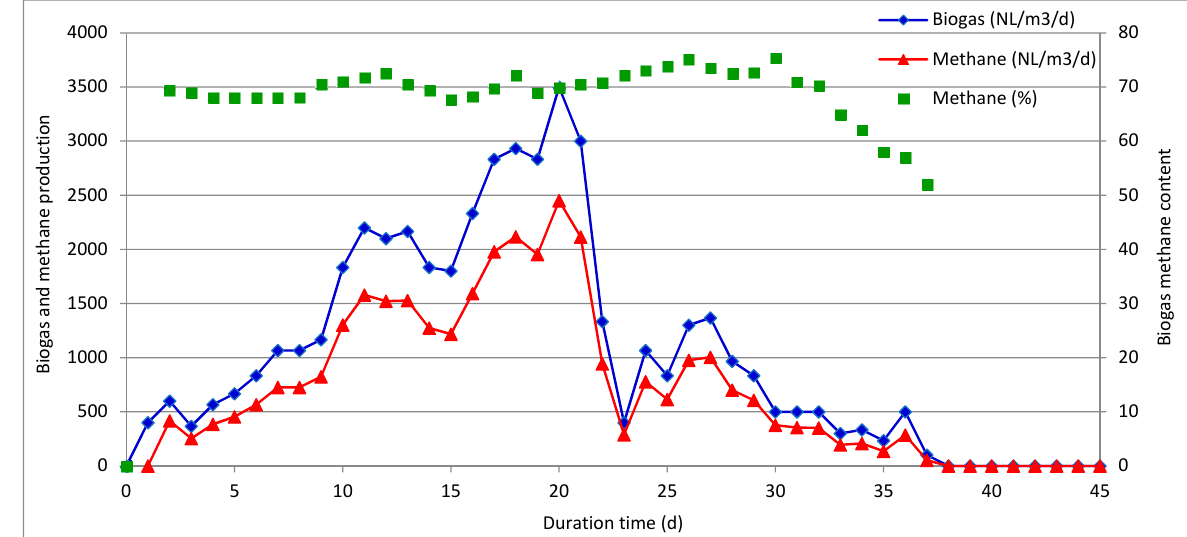
Figure 3. Biogas and methane production reported during the semicontinuous anaerobic co-digestion of ASW, IF, and MONG with SRT of 30 days (experiment R-1).